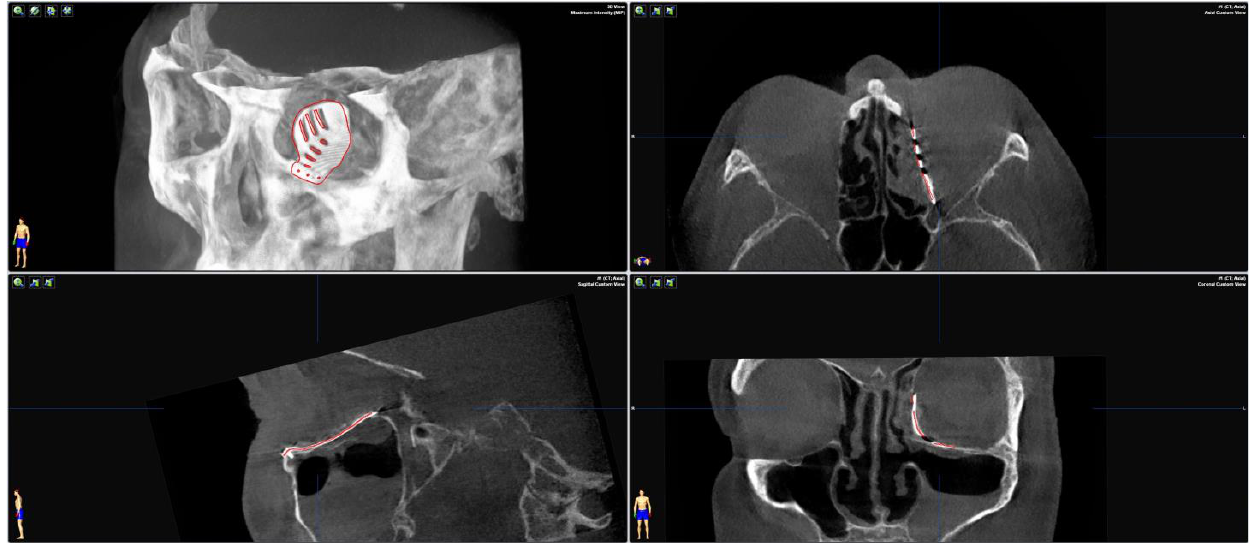
Figure 4. Merging the pre-operative planning CT data with the post-operative CBCT scan confirms correct positioning as the virtually planned patient-specific implant co-localizes with the inserted implant.